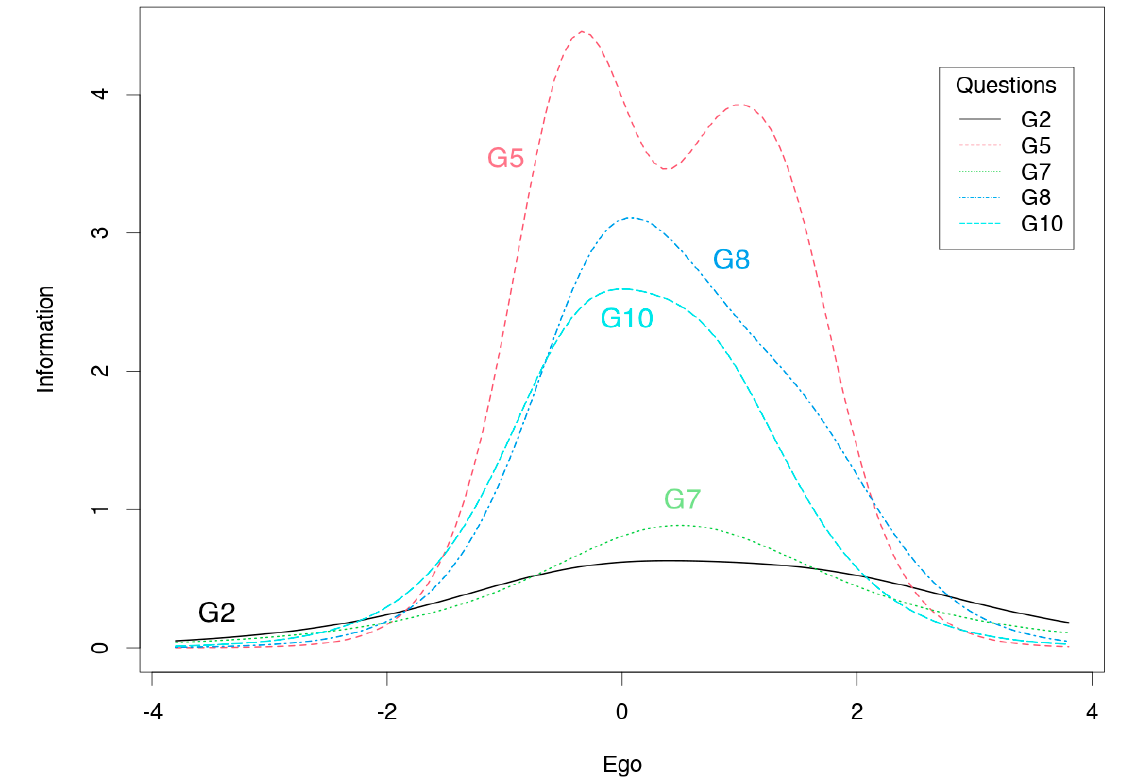
Figure 4. Information curves for the ego scale items of the GOEM scale.